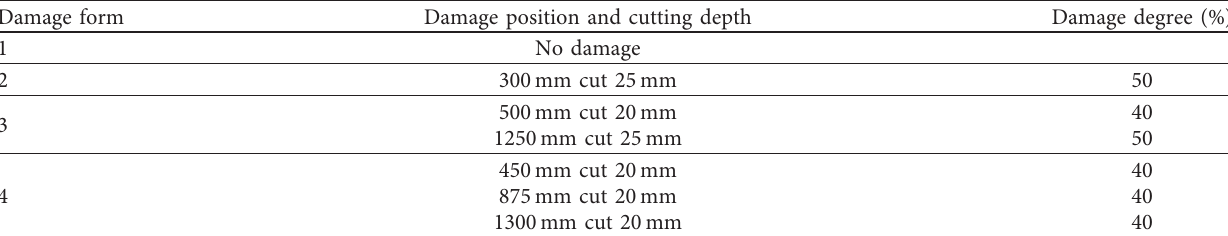
Figure 28: Damage form of steel beam. (a) Steel beam damage case. (b) Steel beam notch form. Table 6: Damage forms of tested steel